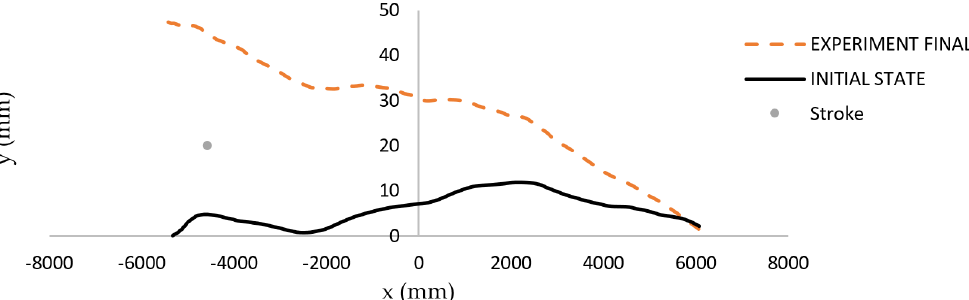
Figure 18. Shape of the fourth exemplary billet before straightening (solid curve) and after straightening (dashed curve) in regime 4.